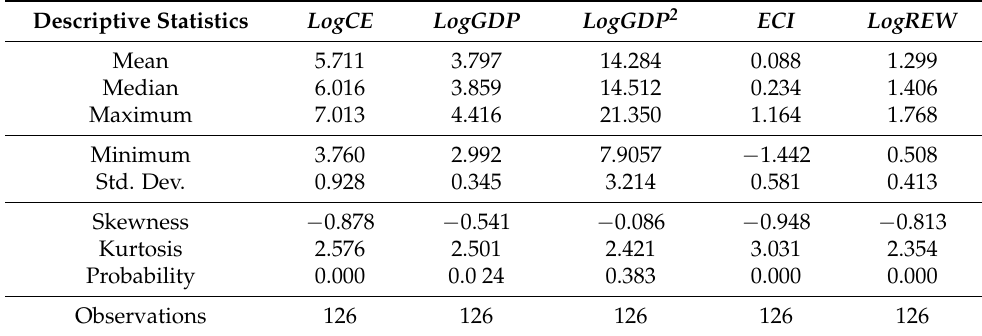
Table 2. Descriptive